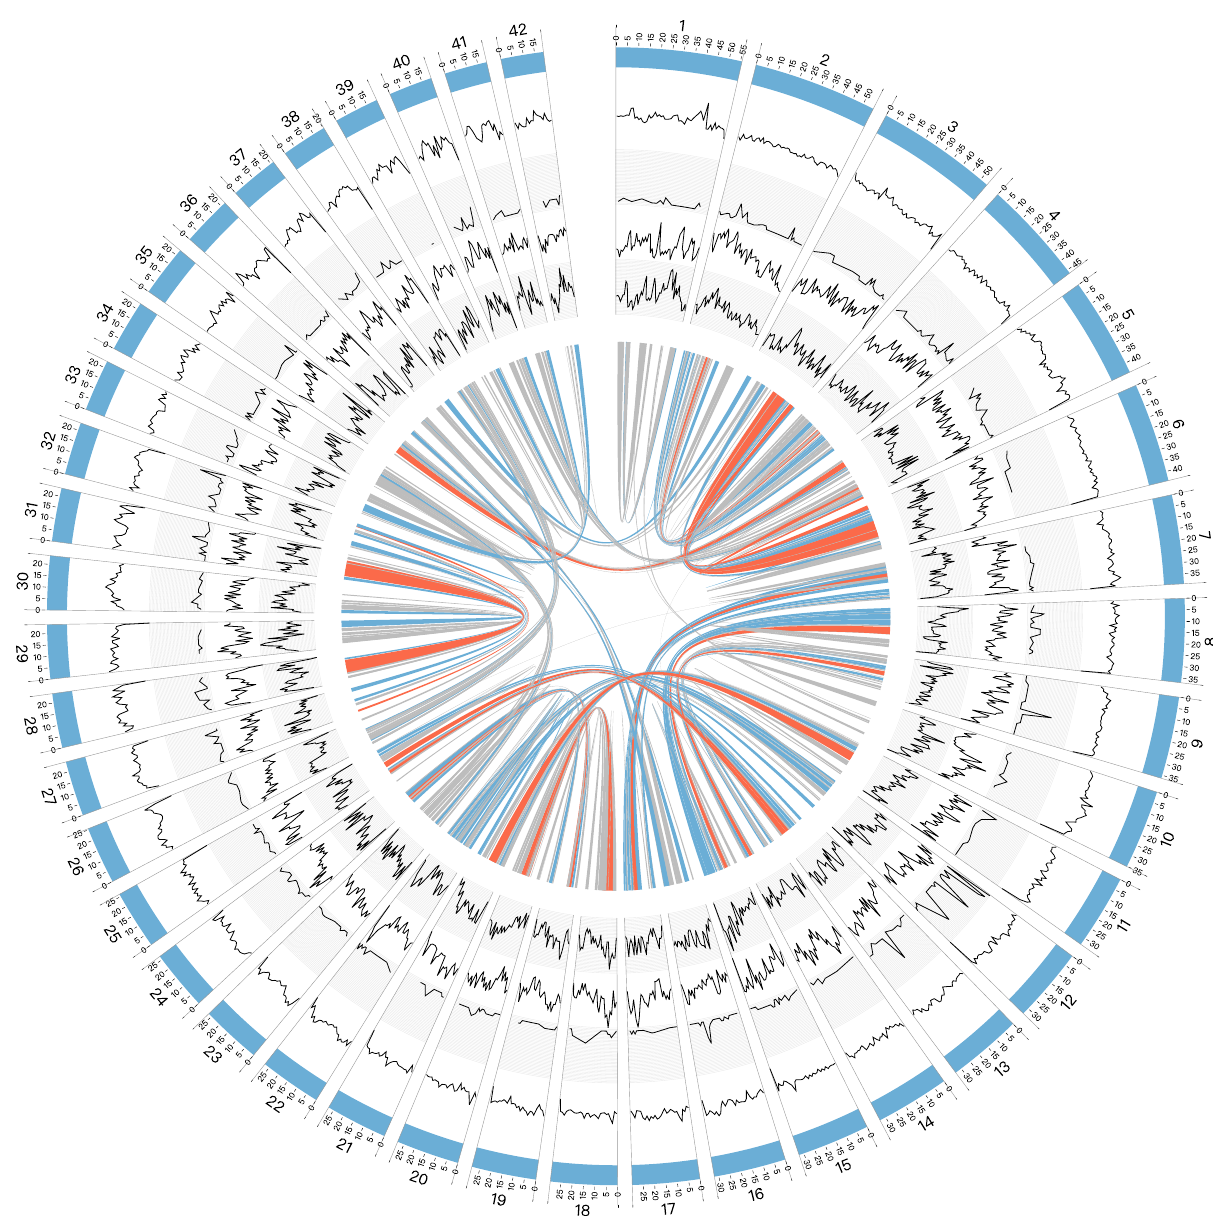
Fig. 1 The genome overview of Amynthas corticis . The outermost ring represents the longest 42 scaffolds. Then, from outside to inside, four rings represent the density distribution of different kinds of genomic elements annotated in the genome, including repeat sequences, non-coding genes, coding genes, and SNPs. Connecting lines in the center represent synteny blocks or duplicated genomic regions detected by MCScanX. The gray, blue, and red colors of the connecting lines represent alignment scores produced by MCScanX that are lower than 500, between 500 and 1000, and greater than 1000,